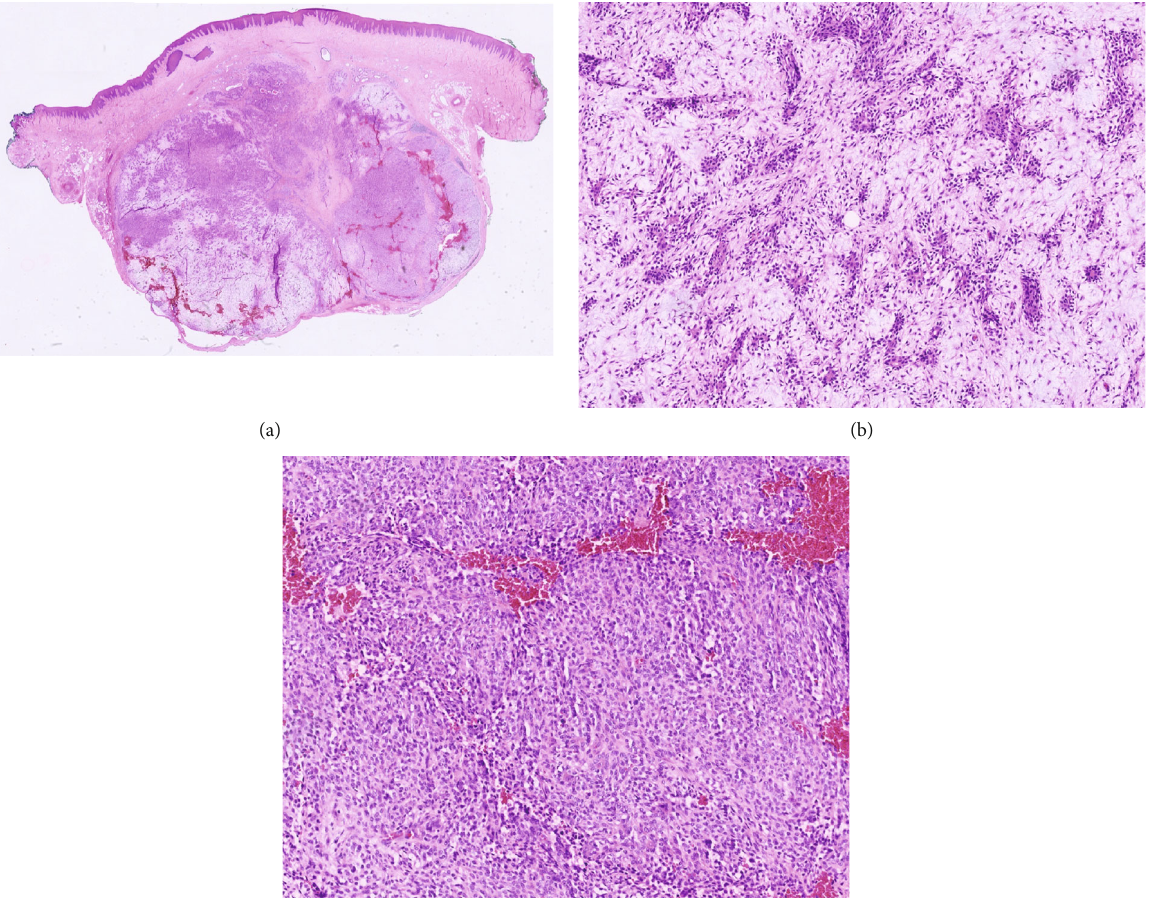
Figure 6: (a – c) Histopathological examination of the tissue showed a mucosal excision. In the submucosal stroma, there was a multinodular tumor consisting of 2 components. One component showed solid fi elds of cells with round to oval nuclei and eosinophilic cytoplasm. There was also a component of spindled cells within a myxoid matrix, with perivascular condensation of the cells. The tumor was clearly demarked from the surrounding stroma.